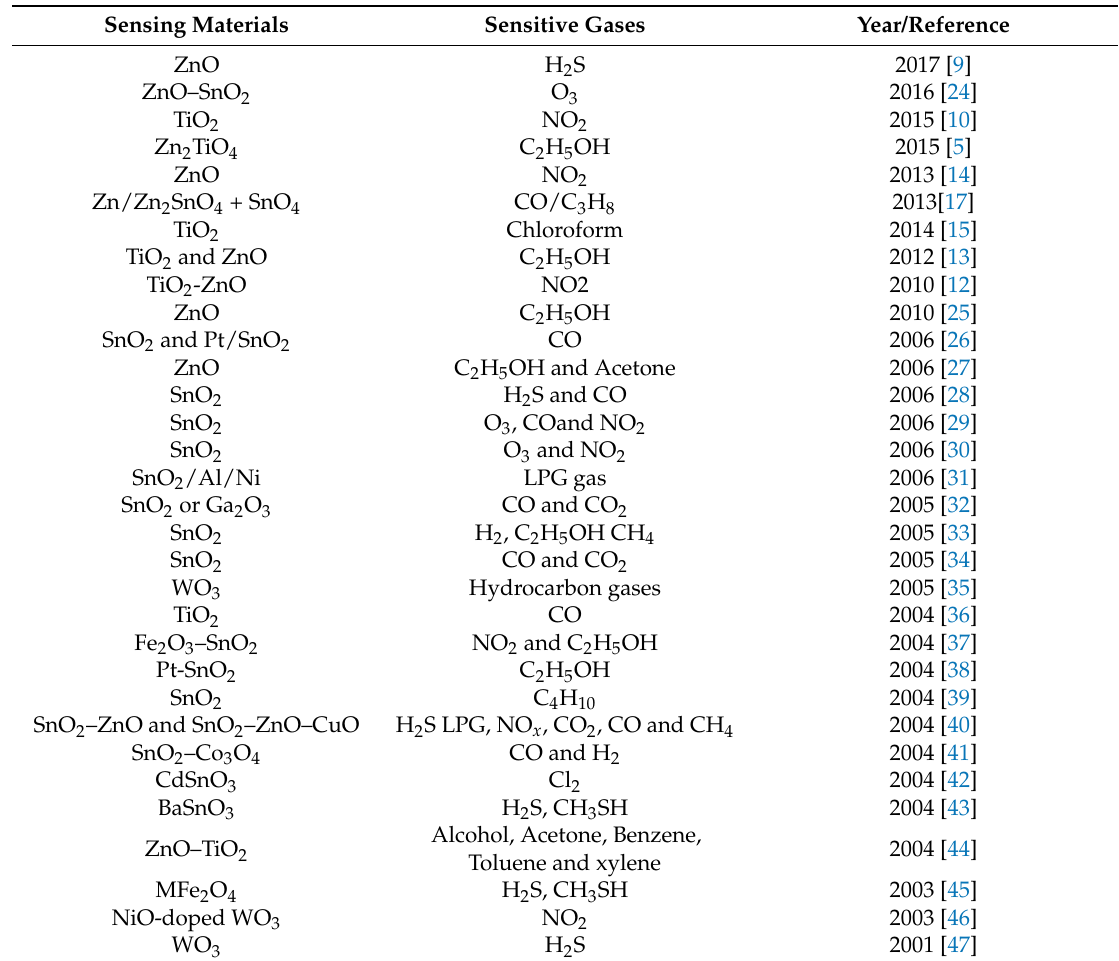
Table 1. List of selected sensing materials for sensing different